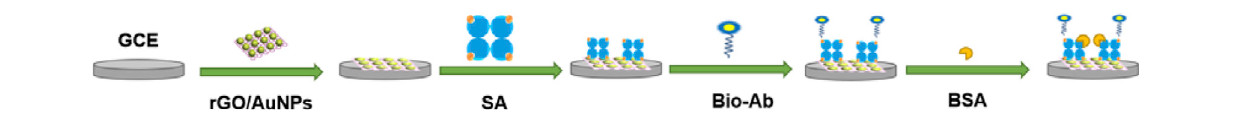
Frontiers in Chemistry |